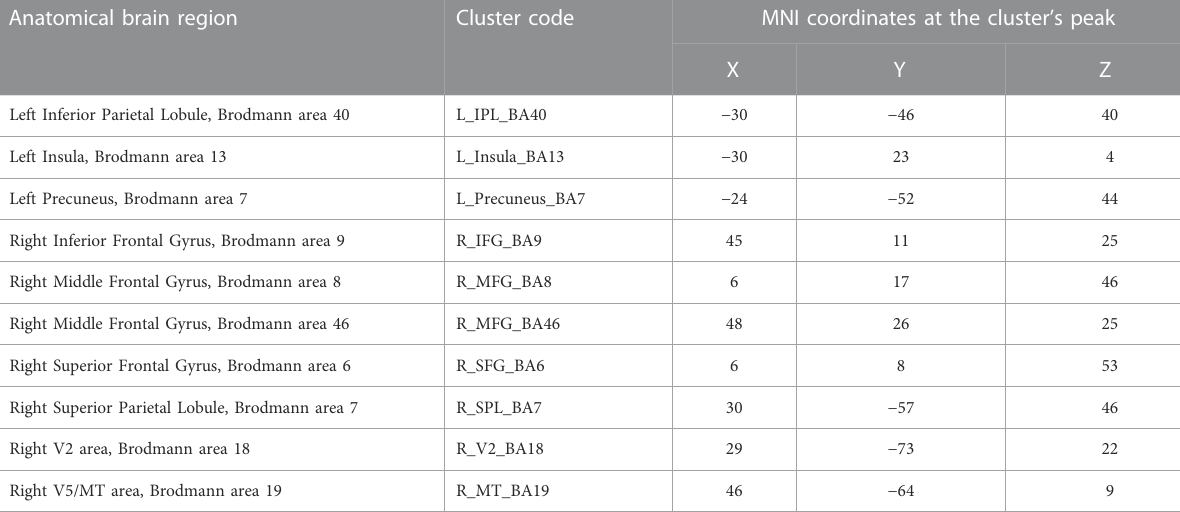
TABLE 2 Clusters with positive signal change during stimulation